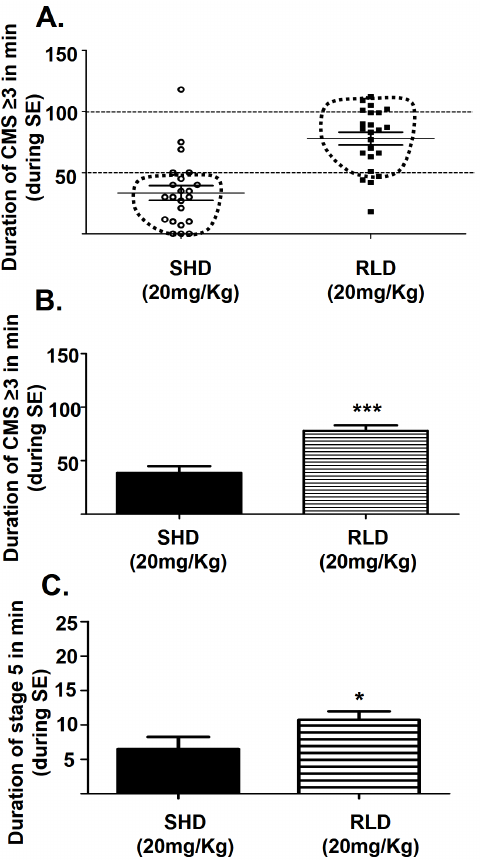
Figure 4. Seizure severity (total amount of time spent in CMS) comparison between SHD and RLD at 20 mg/kg (total dose in RLD or a single dose in SHD group). A–C: Suggests that the RLD method produces consistently severe seizures when compared to SHD. Each point on graph A represents an individual mouse at a specific CMS stage. B: Histogram comparing the mean 6 standard error of seizure severity in SHD and RLD groups (both groups received a total of 20 mg/ kg KA) based on the total amount of time spent in CMS during the 2 h SE period from the time the mice showed first CMS-3 (SHD) or CMS-5 (RLD) to the time they received diazepam C: Comparison of the amount of time spent in stage-5 alone between the two groups revealed that the RLD group had more stage-5 seizures than the SHD group (n=19 for SHD; n=33 for RLD; *p=0.049, *** p , 0.0001).